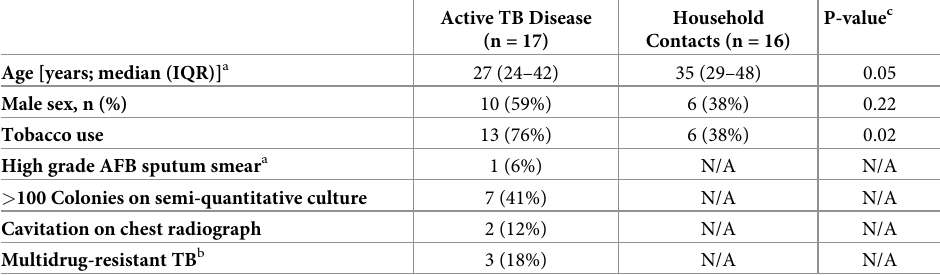
Table 1. Characteristics of patients diagnosed with pulmonary tuberculosis and their asymptomatic household